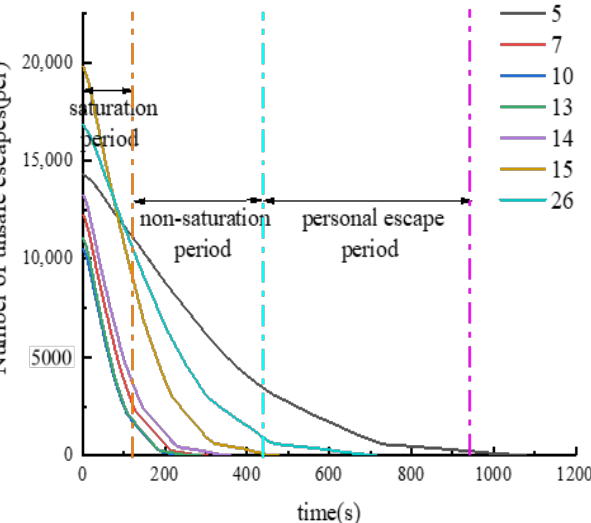
Figure 11. The curve of the number of pedestrians who failed to escape in group B with time.